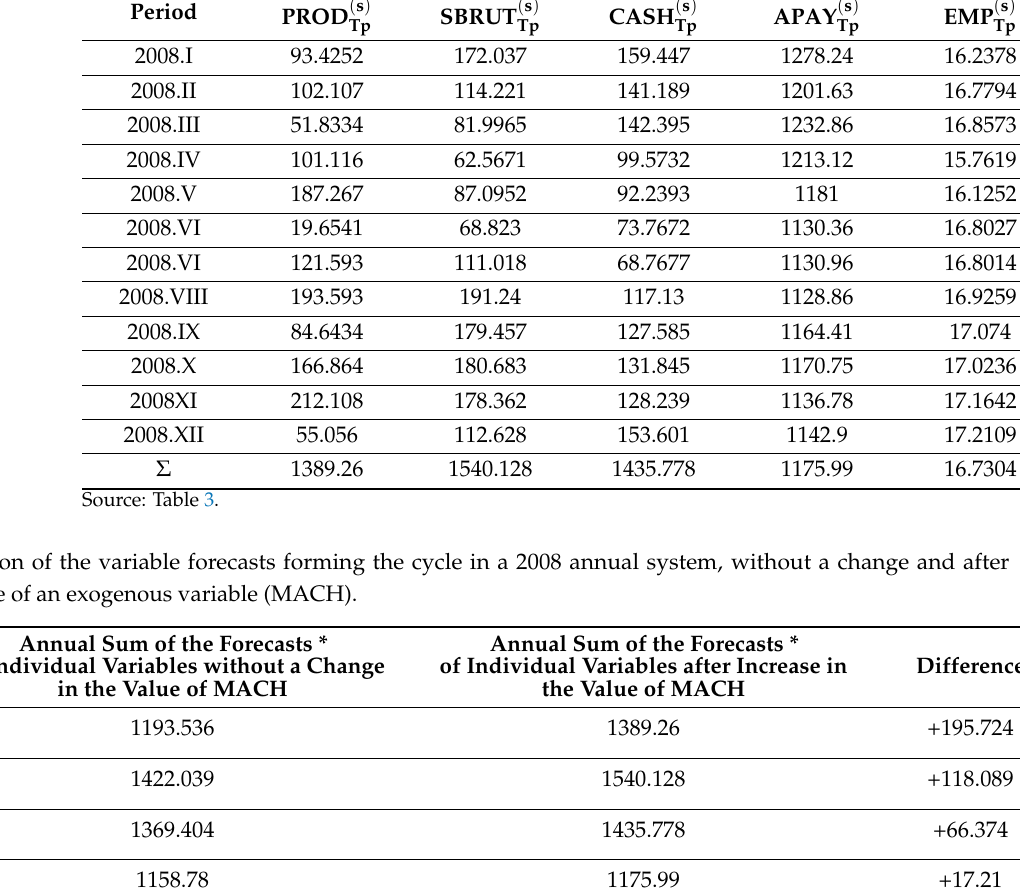
Table 4. Monthly forecasts of the variables forming the cycle, with consideration of an increase in the value of machinery and equipment in 2008.